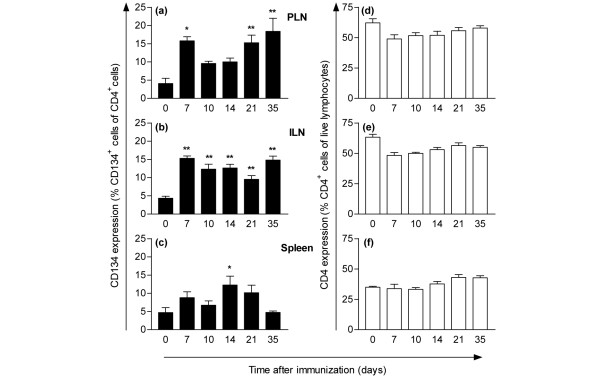
CD134 is differentially expressed on CD4+ cells in secondary lymphoid organs during adjuvant arthritis. Popliteal lymph nodes (a,d), inguinal lymph nodes (b,e), and spleens (c,f) were isolated from Lewis rats before or during adjuvant arthritis (AA) development. Cell suspensions were stained for CD4 and CD134, and cell-associated fluorescence was analyzed by flow cytometry. Results for CD134 (black bars) are depicted as percentages of CD134+ cells of the CD4+ cell population and are expressed as means ± SEM (corrected for isotype control fluorescence). Results for CD4 (white bars) are shown as percentages of CD4+ cells of the live lymphocytes population and are expressed as means ± SEM (live lymphocytes gated based on forward scatter (FSC) and side scatter (SSC) profiles). The data shown are derived from four independent experiments and represent n = 5 to 7 rats per group for t = 0, n = 2 rats per group for t = 7, n = 3 to 7 rats per group for t = 10, n = 5 to 8 rats per group for t = 14, n = 5 to 9 rats per group for t = 21, and n = 4 to 6 rats per group for t = 35. *P < 0.05 compared with t = 0, **P < 0.01 compared with t = 0.